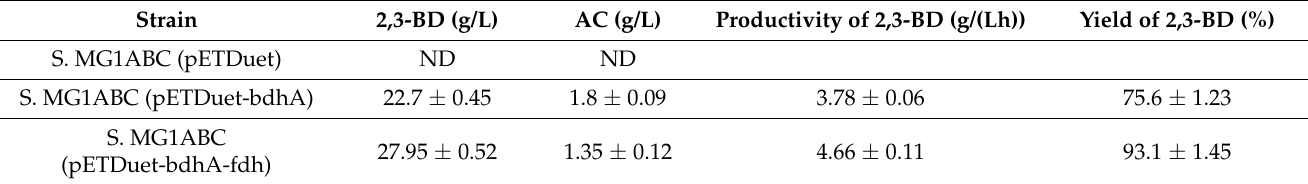
Table 2. The products of batch bioconversion using different cofactor regeneration systems.